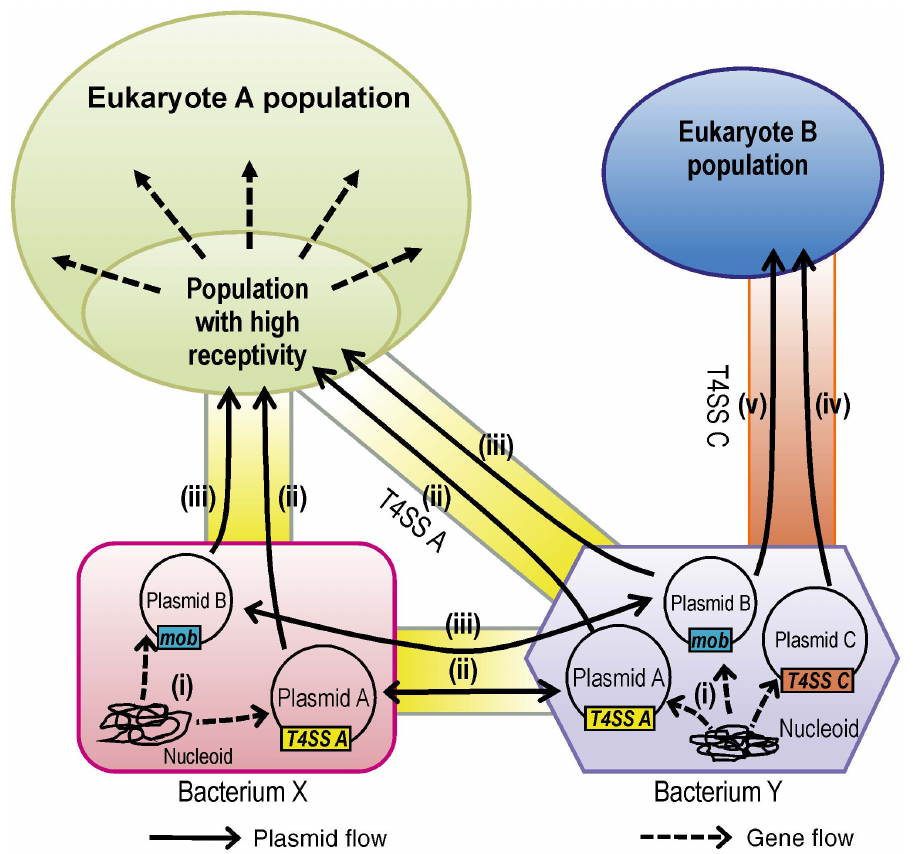
Figure 6. A schematic diagram of the gene and plasmid flow from bacteria to eukaryotes by T4SS. In bacteria X and Y, genes are transferred from genomic DNA to various plasmids depicted as A, B, and C by using transposons or another method (i). A conjugative plasmid A (such as IncP plasmids) can move from bacterium X to another bacterium Y or to a eukaryote A by its own T4SS system, i.e., T4SS A (ii). A mobilizable plasmid B (such as IncQ plasmids) transfers from bacterium X to Y and eukaryote A with the help of its own mob genes and T4SS A (iii). The plasmids A and B can also transfer from bacterium Y to eukaryote A by T4SS A (ii and iii). The eukaryote A has a subpopulation that accepts exogenous DNA efficiently transferred by T4SS A. The transferred bacterial genes spread and are maintained in the entire population, if they take on available roles, for its survival. In bacterium Y, a plasmid C transfers to eukaryote B by T4SS C (such as vir genes in Ti and Ri plasmids; iv). The plasmid B is also able to transfer to eukaryote B by using mob genes and T4SS C